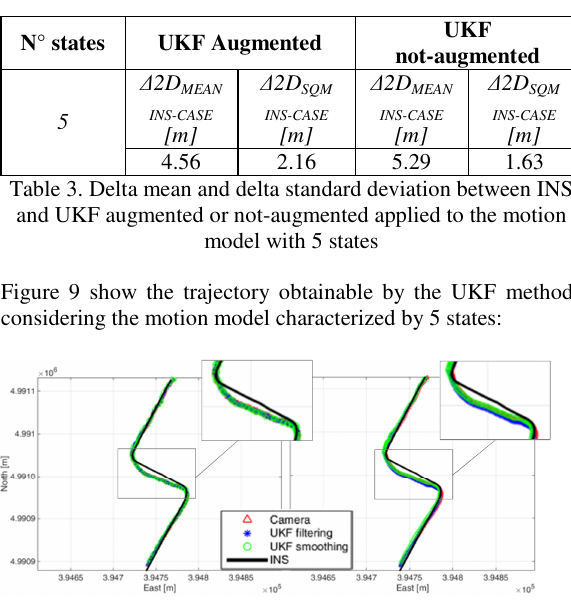
Figure 9. On the left: UKF augmented trajectory with 5 states; on the right: UKF not-augmented trajectories with 5 states The trajectory shown in Figure 9 are quite the same. velocity of DMI (in red), and the values obtained with UKF filtering (blue) or smoothing (green) augmented or not- augmented.